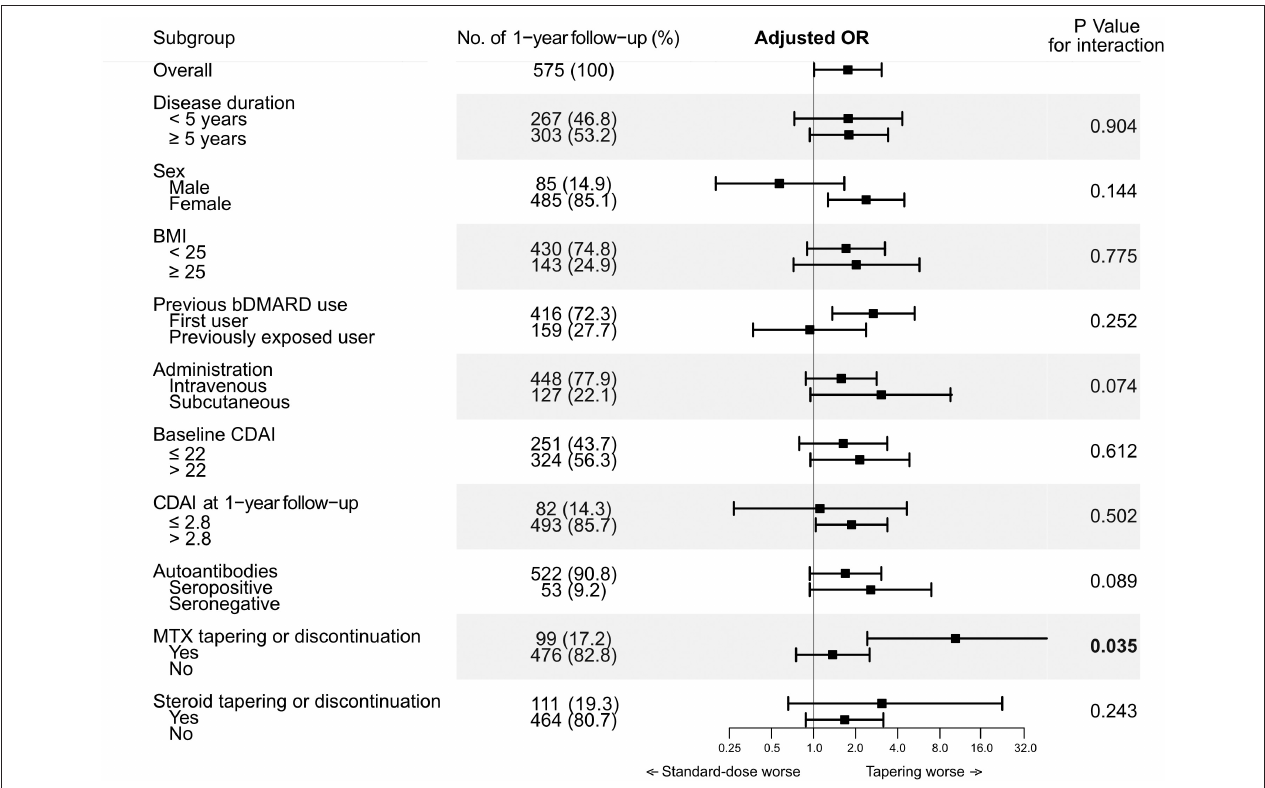
FIGURE 2 | Interaction between tapering tocilizumab and clinical factors on likelihood of maintaining CDAI-LDA.